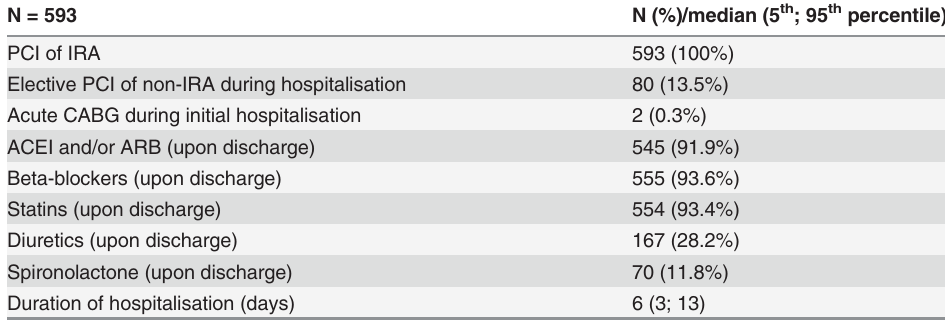
Table 4. Treatment during hospitalisation and upon hospital discharge.